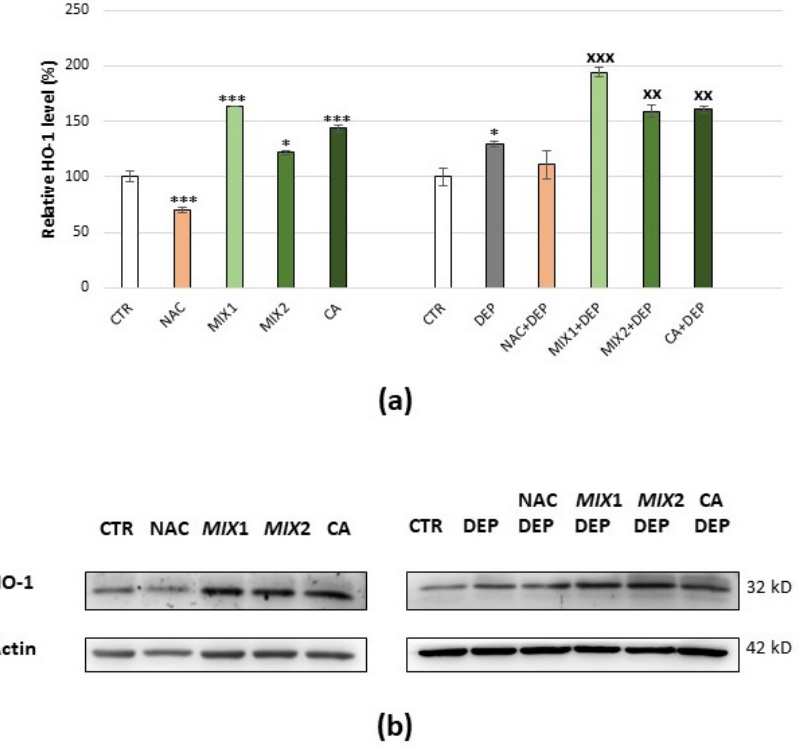
Figure 8. Immunoblotting analysis of HO-1. ( a ) Protein was evaluated following cell treatment carried out only with antioxidants (5 mM NAC for 24 h, 0.5 µ M Mix 1 or 1 µ M Mix 2 or 1 µ M caffeic acid (CA) for 48 h), only with pro-oxidant (25 µ g/mL DEPs for 12 h), and finally with the different antioxidants and subsequent exposure to DEPs. Protein was normalized for the corresponding β -actin signal in each lane, and expressed as a percentage of the control. Values represent mean ± SE obtained from three independent experiments. * p < 0.05 versus control, *** p < 0.001 versus control, XX p < 0.01 versus DEPs, XXX p < 0.001 versus DEPs. ( b ) Corresponding representative immunoblotting images.